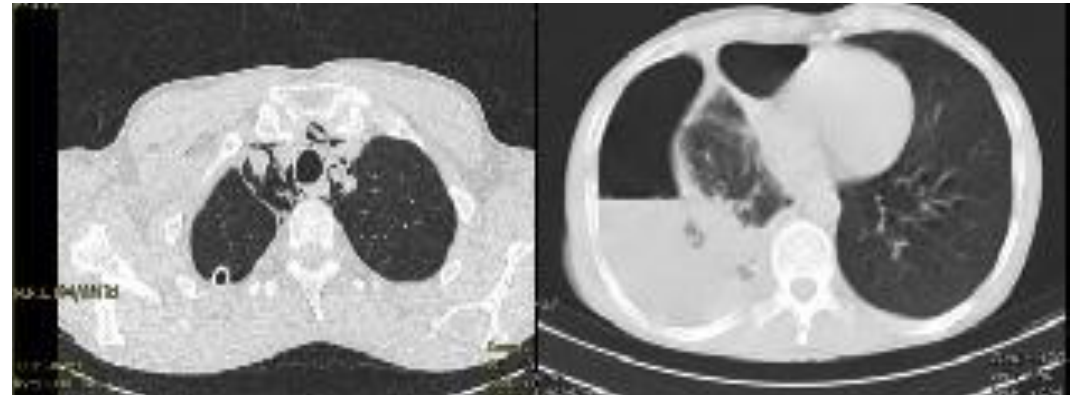
Figure 2. Chest CT scan with hydropneumothorax and